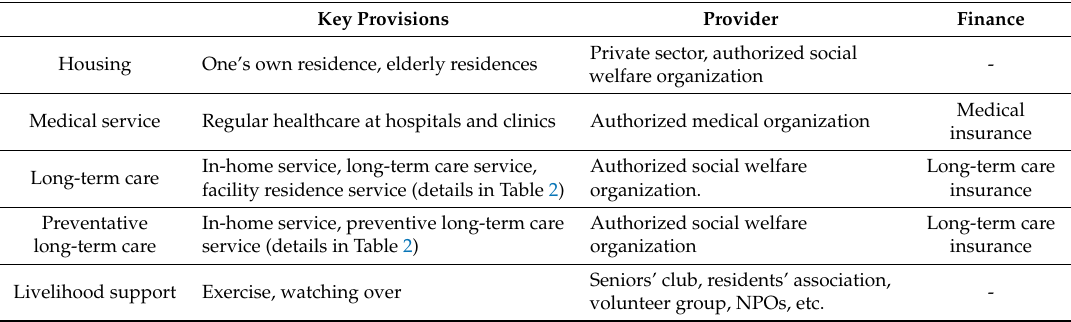
Table 1. Community-based Integrated Care System (information from Ministry of Health, Labor and Welfare (MHLW) [23]).